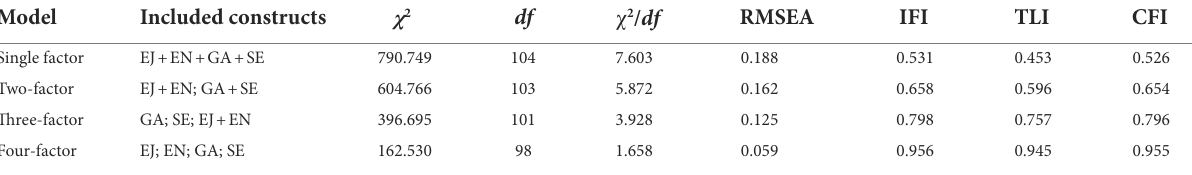
TABLE 1 Confirmatory factor analysis results. Model